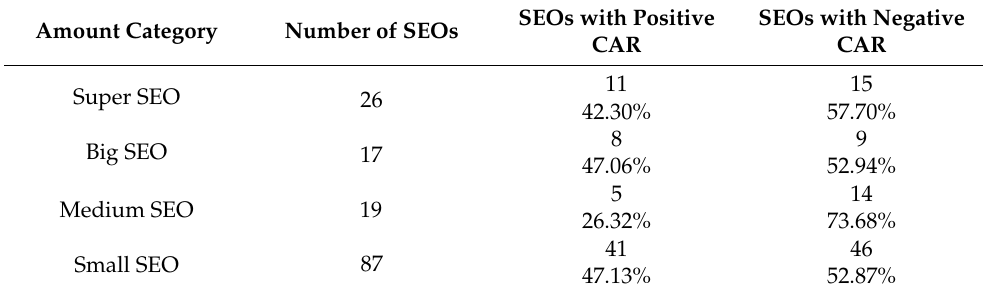
Table 3. Effects of seasoned equity offerings (SEOs) on share price (volume categories). Amount